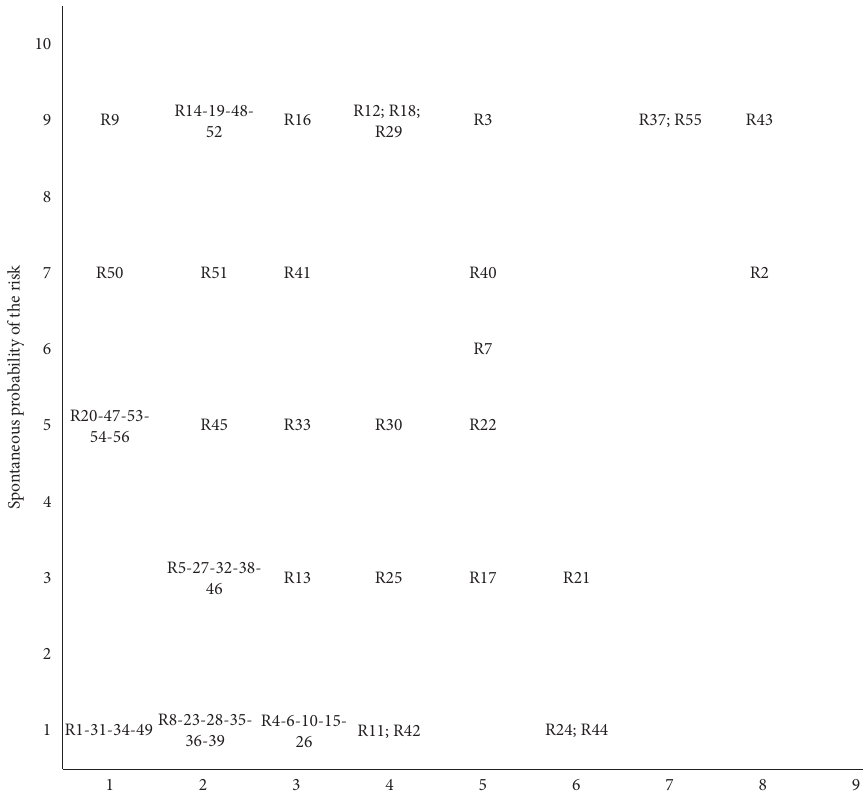
Figure 4: Initial Farmer diagram of the tramway